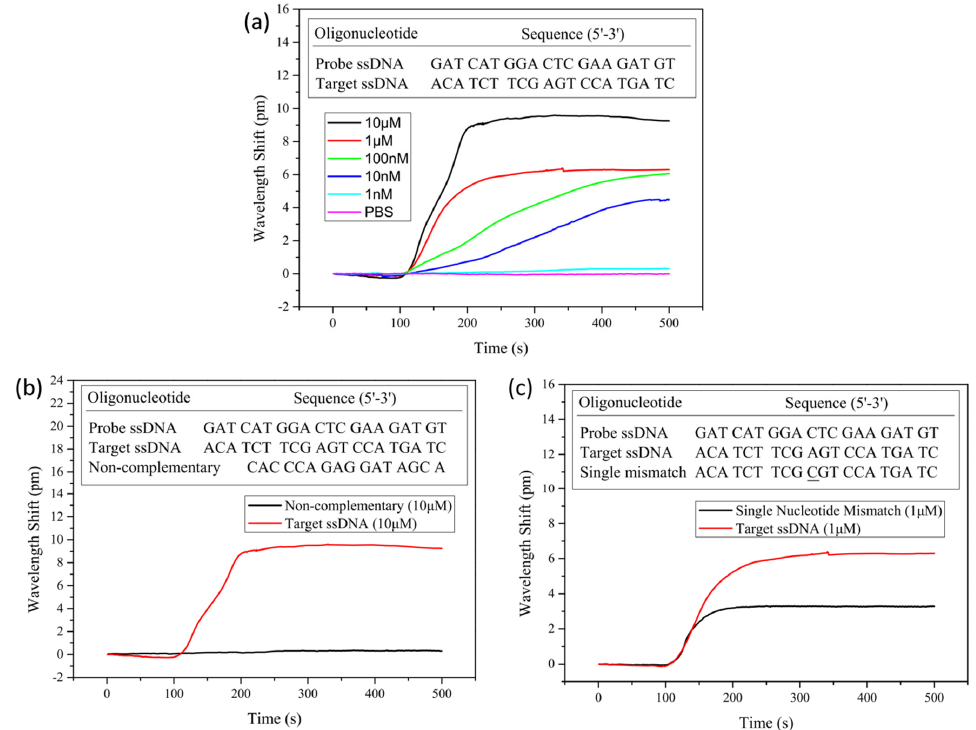
Figure 24. ( a ) Wavelength shifts from Target ssDNA binding over time. ( b ) Target ssDNA wavelength shifts compared to equal concentrations of non-complementary strands and ( c ) single nucleotide